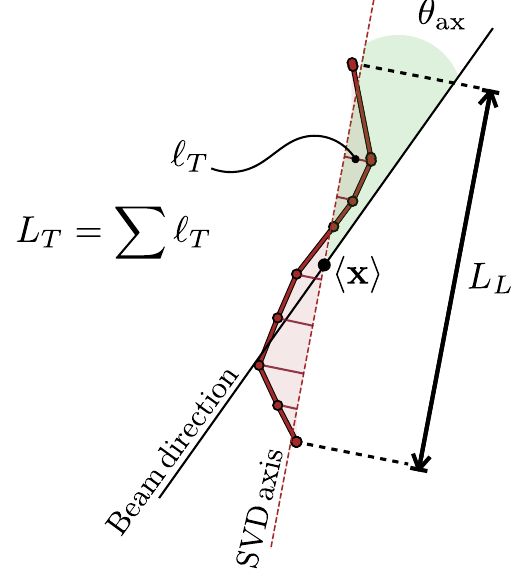
Fig. 7 Diagram of geometrical quantities that can be extracted from a sequence of DNA strand break sites. We can use L L to parameterise the longitudinallengthofthetrackandthe L T toparameterisethetransverse extent of the track. Since L L is typically larger than the detector, we can use L T to perform some comparisons between different particle types and energies. We also define θ ax to be the axial scattering